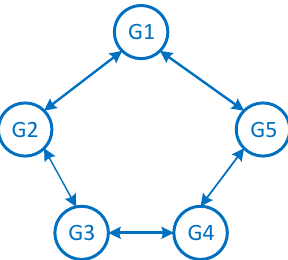
Figure 7. Communication topology of five generators: loop